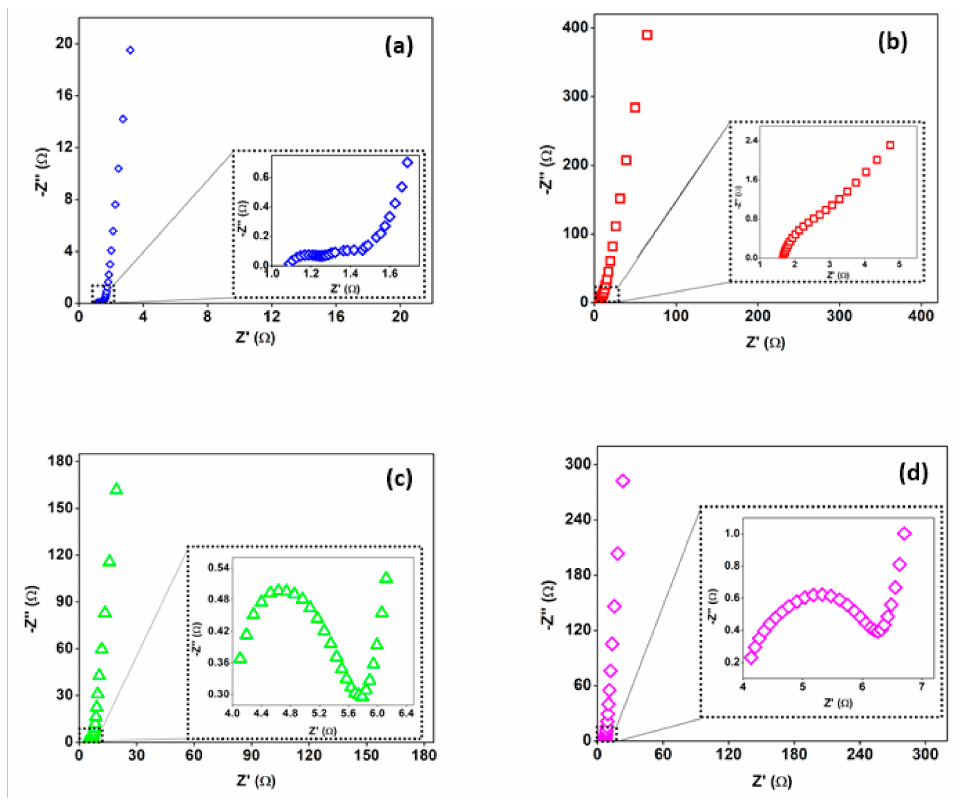
Figure 10. Electrical impedance spectroscopy (EIS) curves of ( a ) CN-R, ( b ) CN-300, ( c ) CN-400, and ( d )